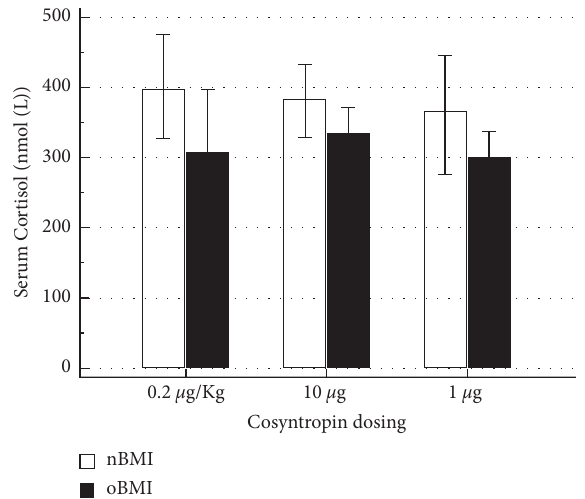
Figure 1: Basal serum cortisol (nmol/L) comparison across tests between normal weight (nBMI) and individuals with obesity groups